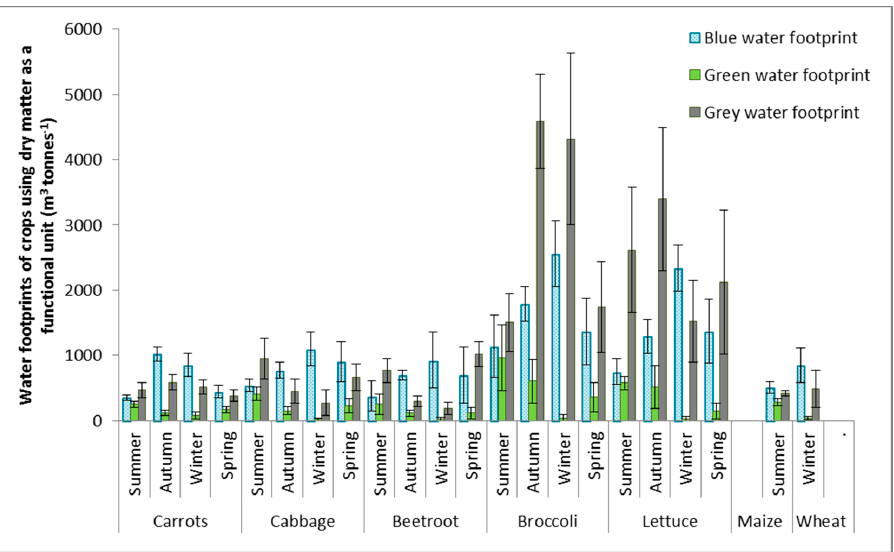
Figure 7. Average of 10 years’ blue and green water footprints (2004–2013) with standard deviations (shown as error bars) of vegetable and grain crops in the different growing seasons on the Steenkoppies Aquifer using dry matter as a functional unit.